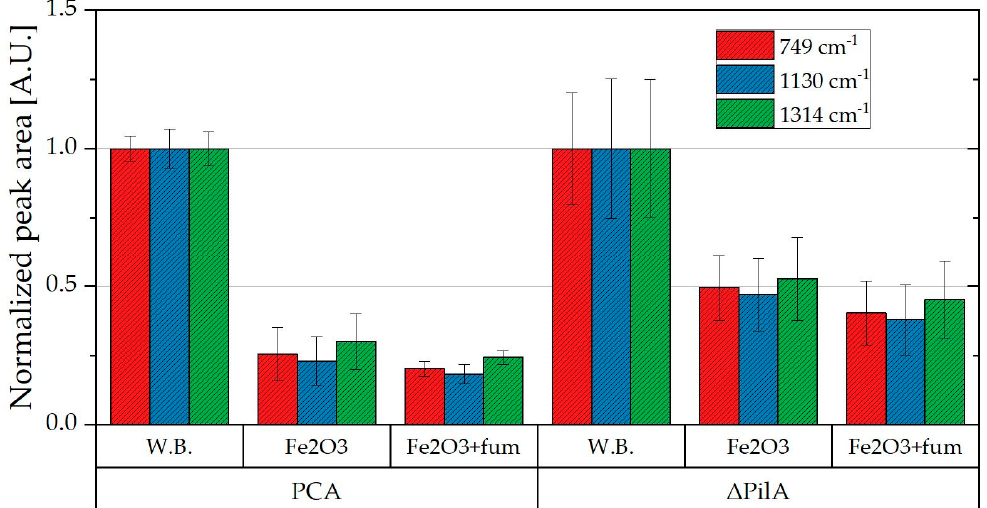
Figure 5. Normalized Raman peak areas of PCA and ∆ pilA samples grown in a chemostat, suspended in a wash buffer (W.B.) and the same samples after the sequential addition of Fe(III)oxide and fumarate. (The error bars show the standard deviation of 6–9 Raman measurements).